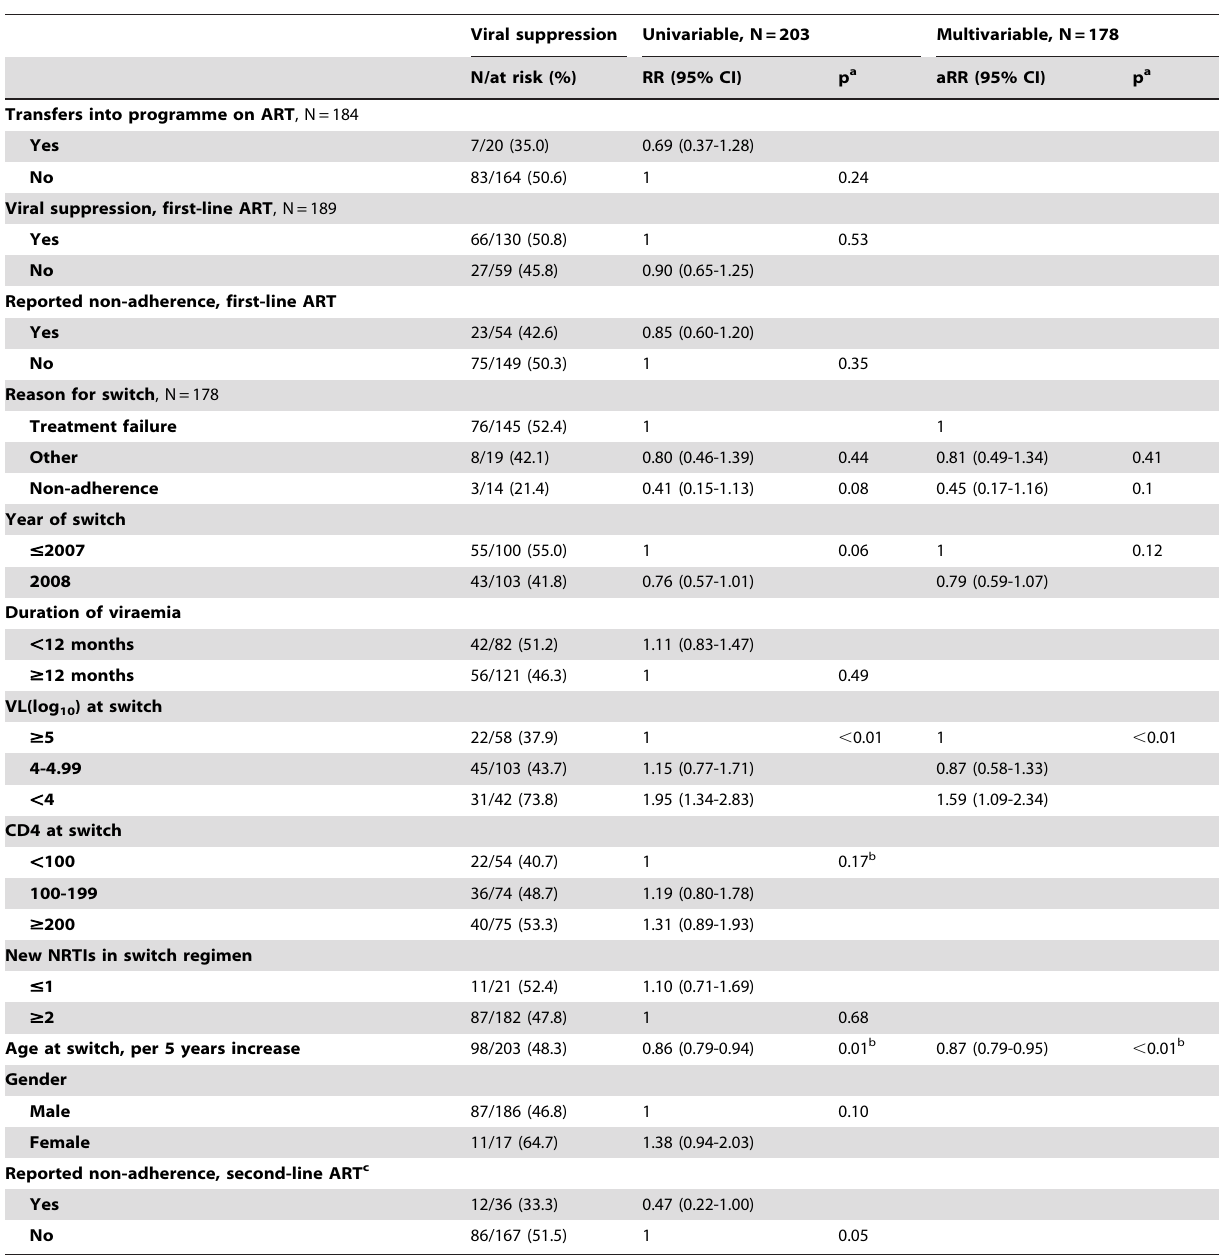
Table 3. Predictors of early viral suppression (viral load , 400 copies/ml) on second-line ART in the workplace